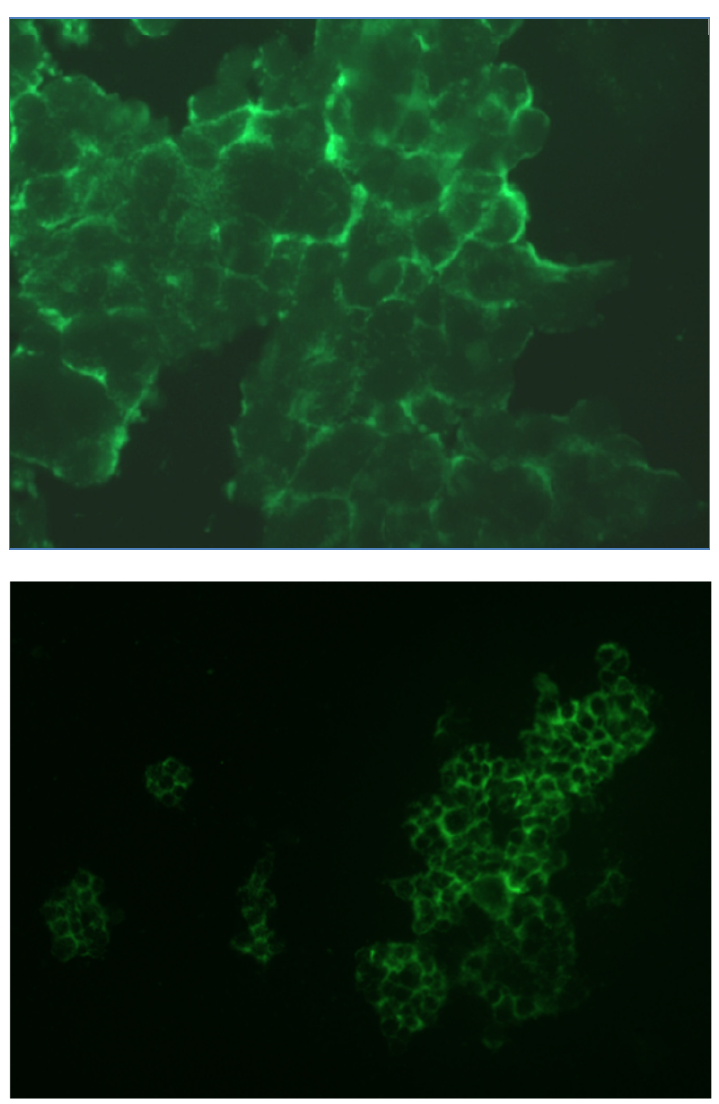
Figure 5. Fluorescence microscopy of FITC-labeled CaIX-P1. Images were performed from two different regions after incubation of HCT116 cells with FITC-CaIX-P1.